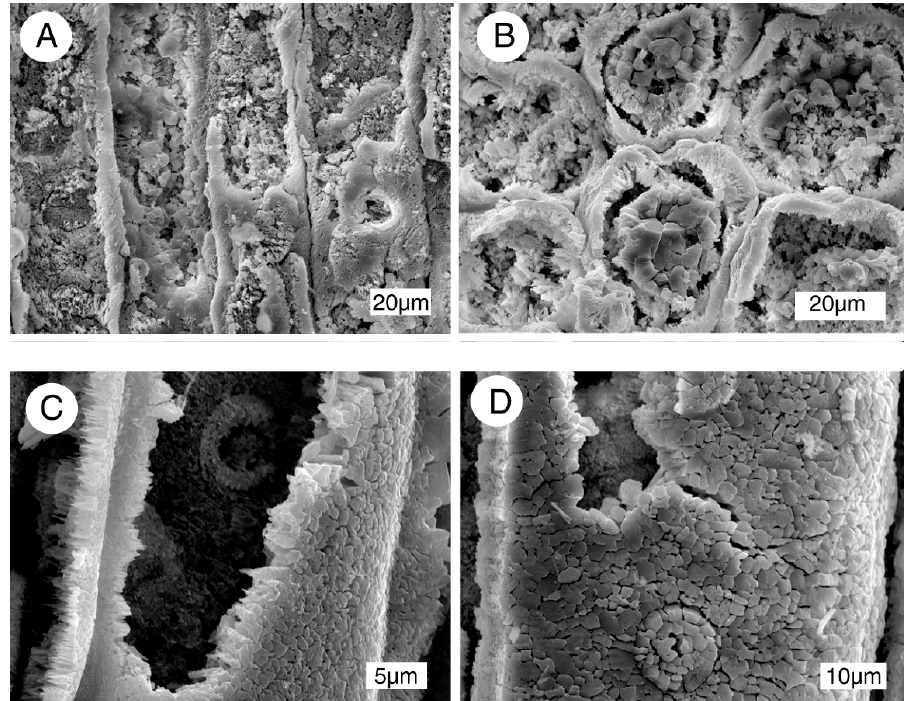
Figure 5. SEM images of Miocene woods after 15 seconds of treatment with 40% hydrofluoric acid. Relict tissue was present during early stages of mineralization, but no relict organic matter is visible in these specimens. The end result meets the definition of replacement, not permineralization. ( A , B ). Specimen from Cedarville, CA, USA. ( A ) Radial orientation, ( B ) transverse orientation. Cell walls are mineralized with fibrous chalcedony. Lumina contain subhedral quartz crystals. ( C , D ) radial views of single tracheids, showing cell walls mineralized with a mosaic of interlocking microcrystals of chalcedony, preserving intervessel pit architecture. Lumina remain empty. ( C ) Saddle Mountain, Grant County, WA, USA; ( D ) Yakima Canyon, Yakima County, WA, USA, showing chalcedony-replaced cell walls with discernable circular pits.